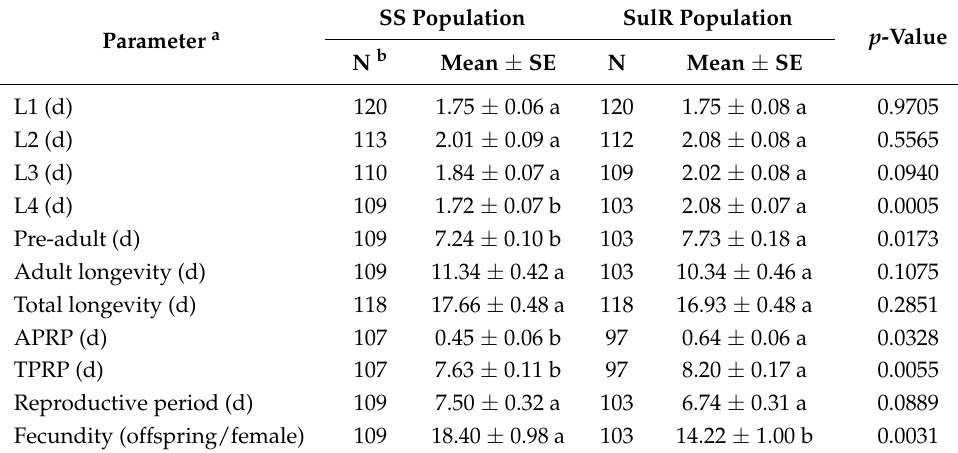
Table 2. Developmental duration and fecundity of sulfoxaflor-susceptible (SS) and sulfoxaflor- resistant (SulR) Sitobion miscanthi populations.